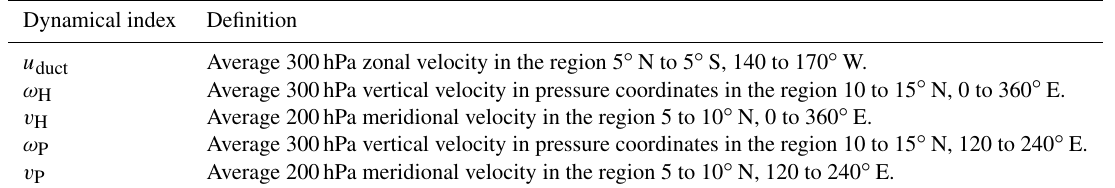
Table 1. Definitions of dynamical indices characterizing eddy and mean tracer transport.